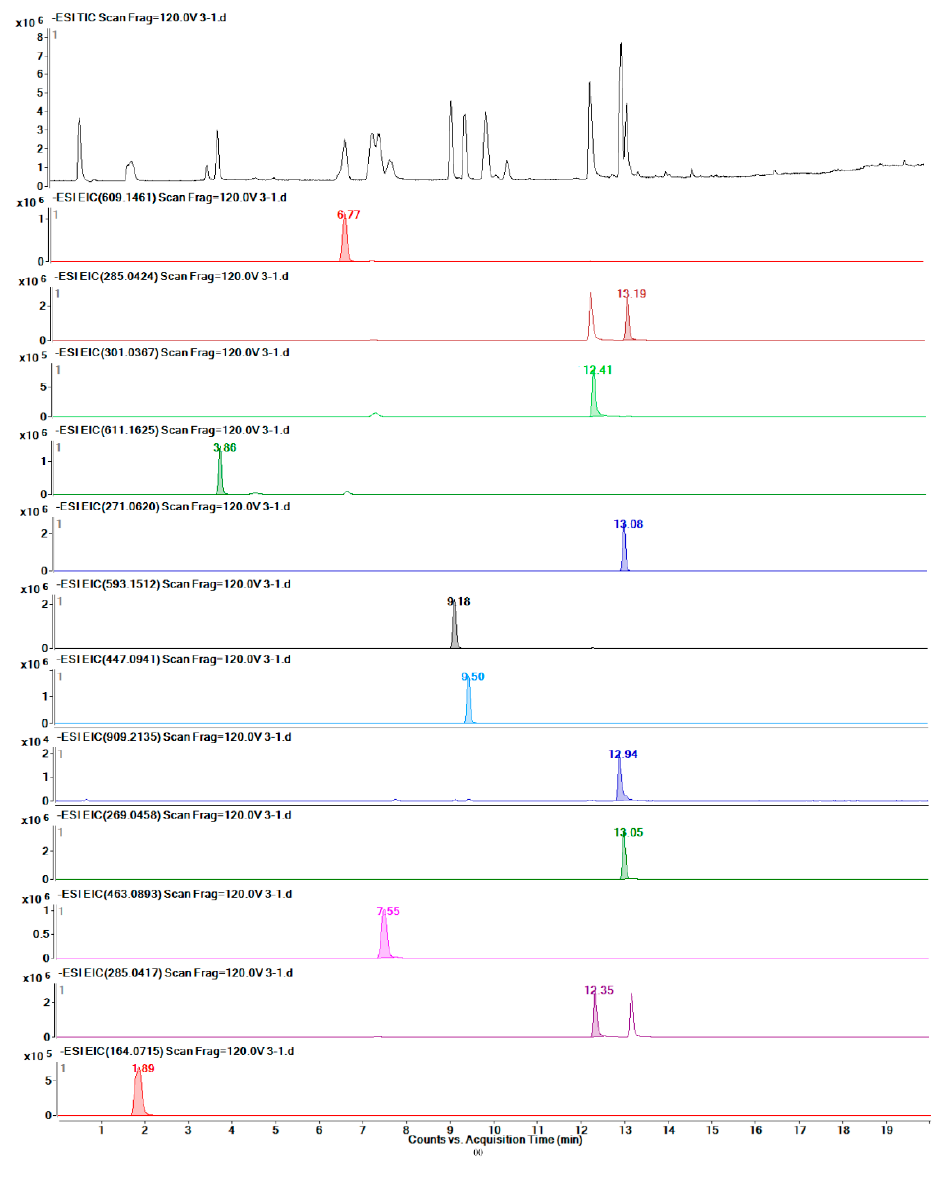
Figure 8. TIC of the mixed standards and EICs of each of the twelve metabolites.